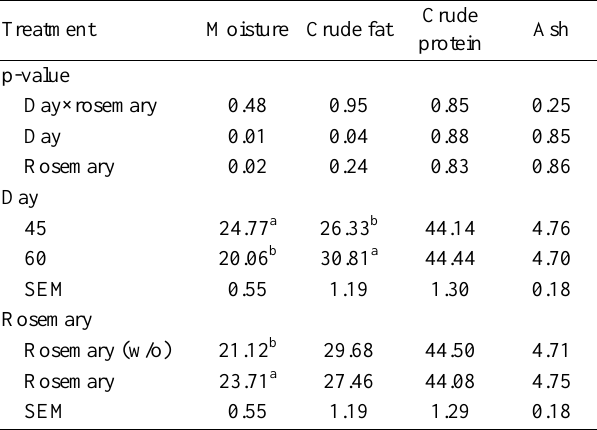
Table 1. Proximate composition of salchichon modified sausages after 45 or 60 d of ripening and/or added rosemary powder